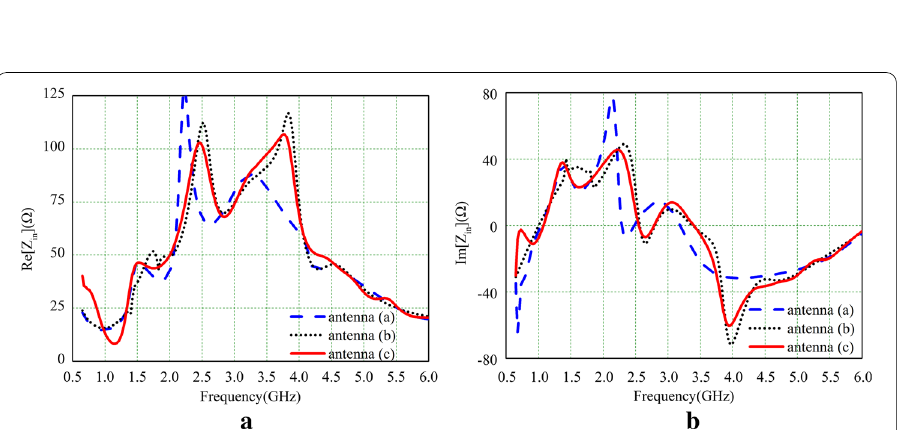
Fig. 5 Input impedance of three kinds of rooftop antennas with different performances. a Real part of input impedance. b Imaginary part of input